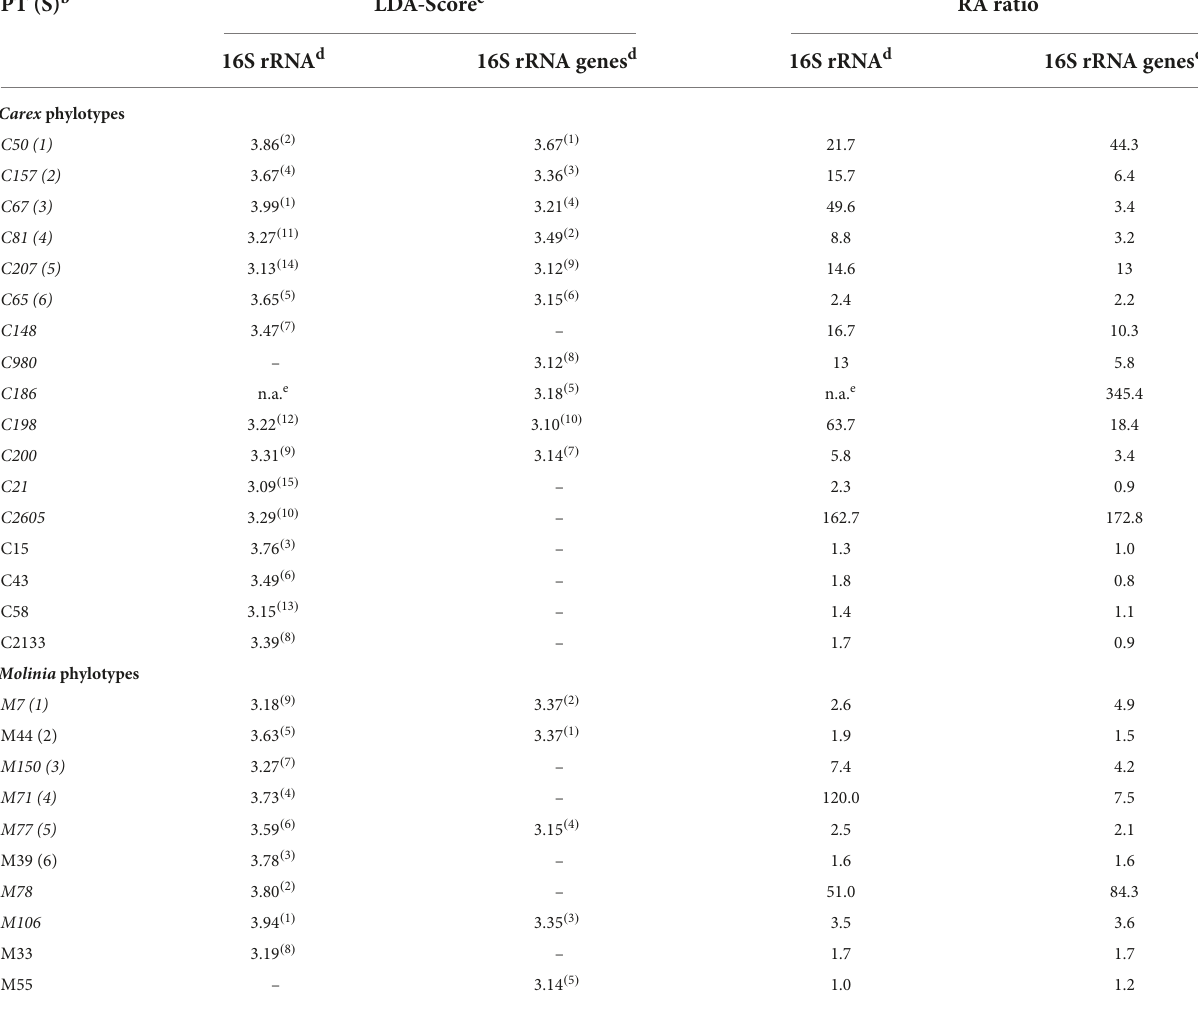
TABLE 2 Phylotypes stimulated by supplemental H 2 in soil treatments a